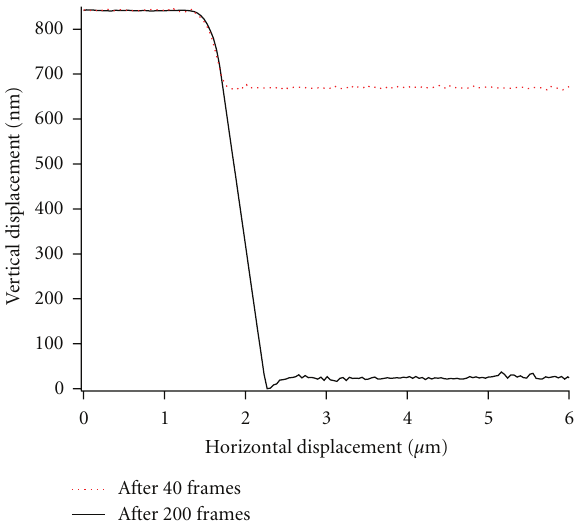
Figure 20: SPM scans of the crater edge in semiconductor laser after 40 and 200 frames using 100pA 20 keV Ga + . The crater wall is not perfectly normal to the crater floor, but the slope remains constant as the crater becomes